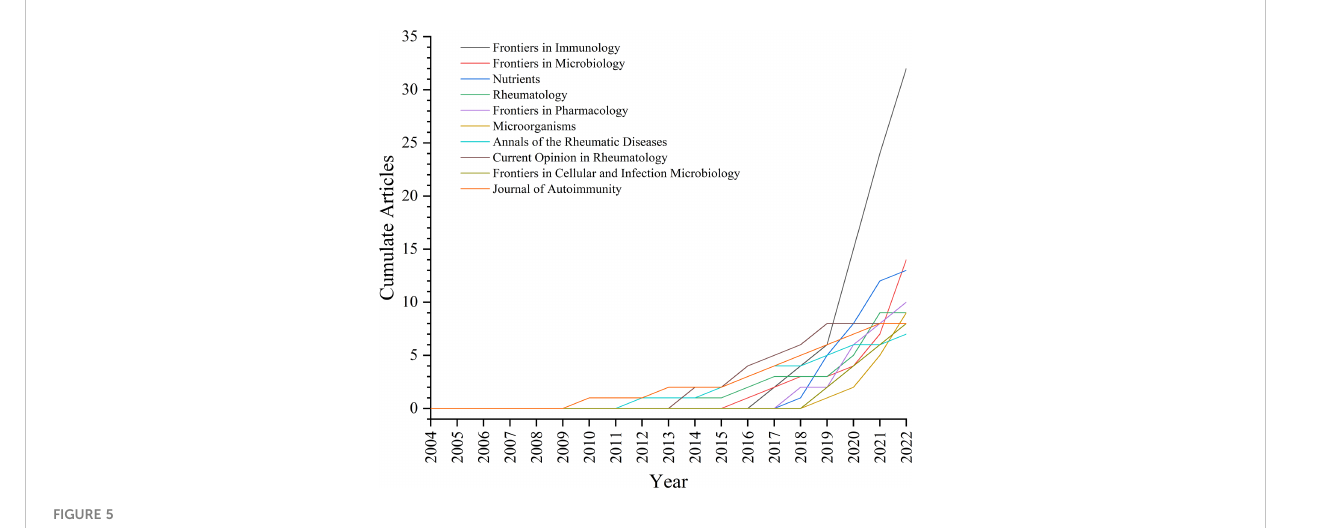
FIGURE 5 Journals ’ production in over time.